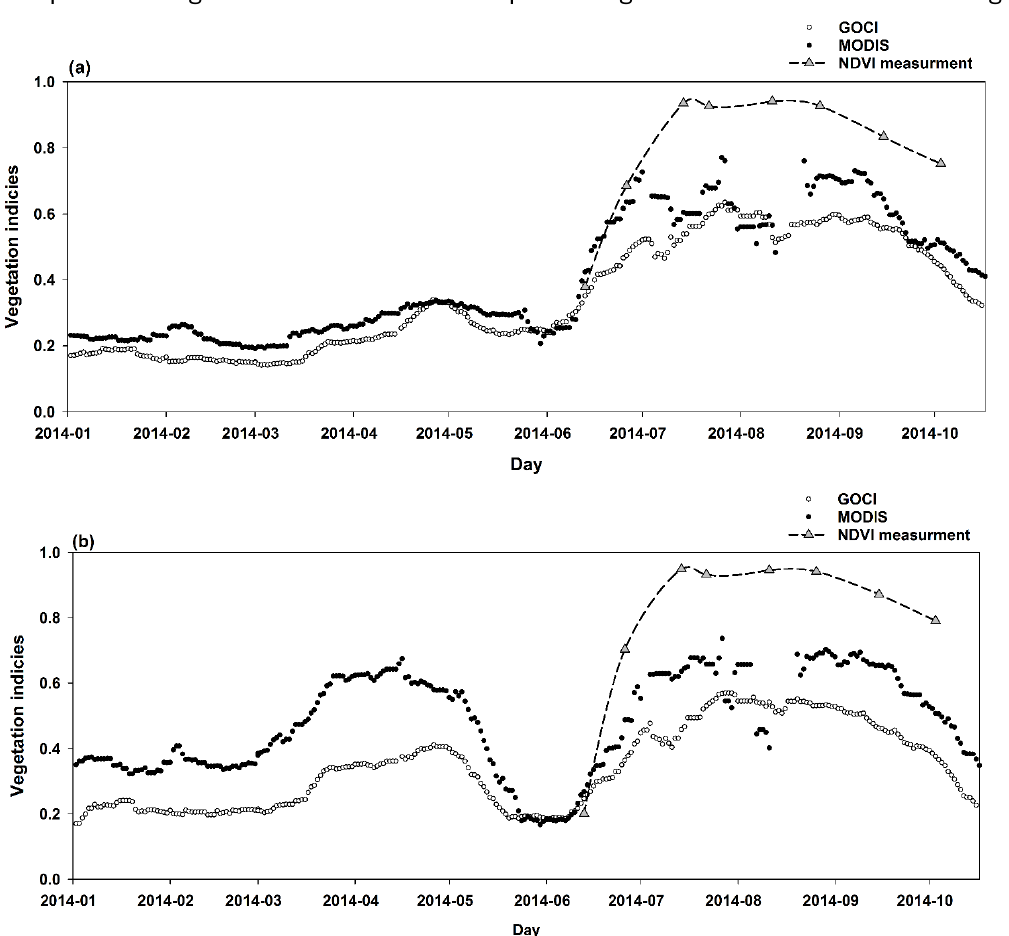
Figure 7. Comparison of temporal BRDF-adjusted NDVI from GOCI (solid circles) and MODIS (open circles) with CROPSCAN measurements (solid triangles) over rice paddy with ( a ) intermediate-late maturing and ( b ) early-maturing rice cultivar during 2014. The dashed line over scan measurements is interpolated NDVI using the cubic spline